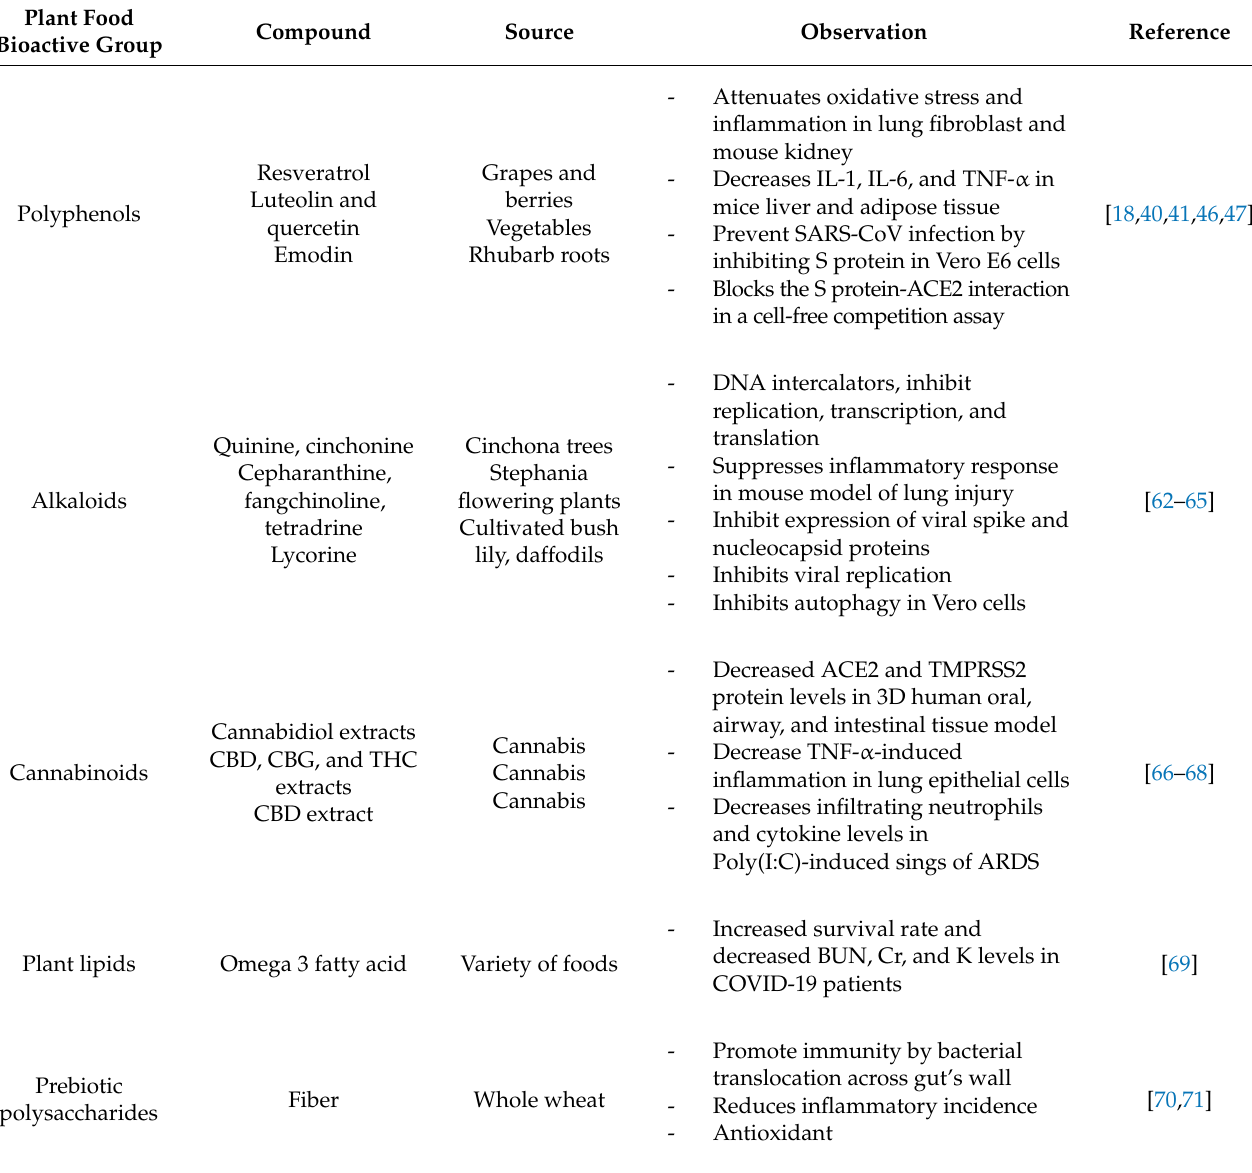
Table 1. Major findings in relation to the potential reduction of the impact of anti-COVID-19 by dietary plant food bioactive